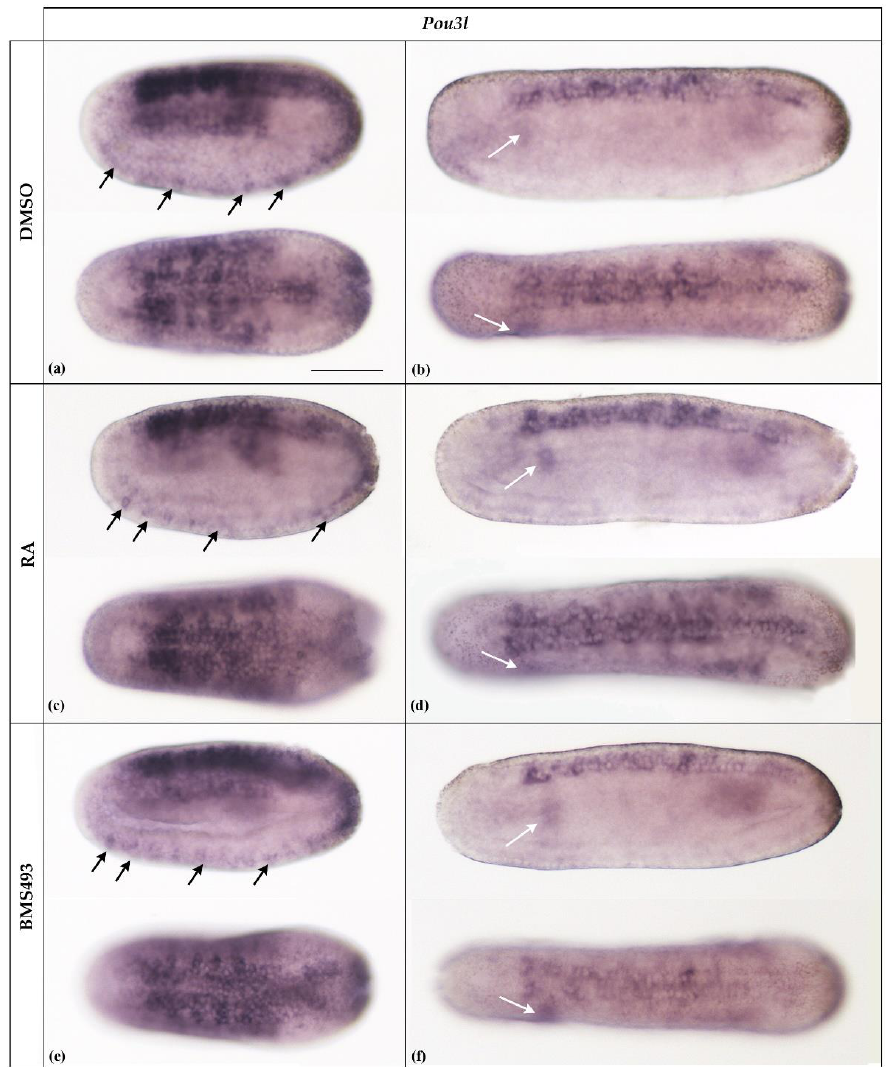
Figure 3. Expression of Pou3l in N2- and N4-stage Branchiostoma lanceolatum embryos. ( a , b ) Control embryos (DMSO-treated). ( c , d ) Retinoic acid (RA) signaling activation with all- trans retinoic acid (RA). ( e , f ) RA signaling inhibition with the inverse agonist BMS493. In N2-stage embryos, Pou3l is expressed in the neural plate, except for the prospective cerebral vesicle, in the somites, and in the precursors of ectodermal sensory neurons located ventrally (arrows) ( a , c , e ). Expression is subsequently downregulated and is only found in the rhombospinal portion of the neural plate and the somites, most conspicuously in the first somite on the left side of the embryo (white arrows), at stage N4 ( b , d , f ). The treatments do not affect Pou3l expression. Whole mount embryos are shown in lateral (top) and dorsal (bottom) views; the anterior is to the left. The scale bar in ( a ) is 50 μm and is valid for all panels.